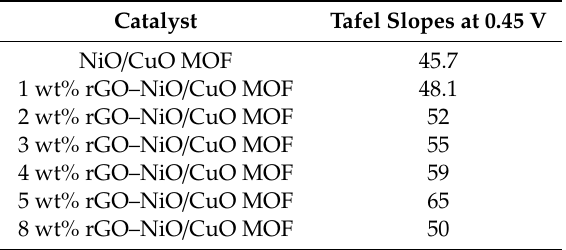
Table 3. Tafel slopes of NiO / CuO MOF and its composites with 1, 2, 3, 4, 5, and 8 wt% rGO–NiO / CuO MOF at 0.45 V. Catalyst